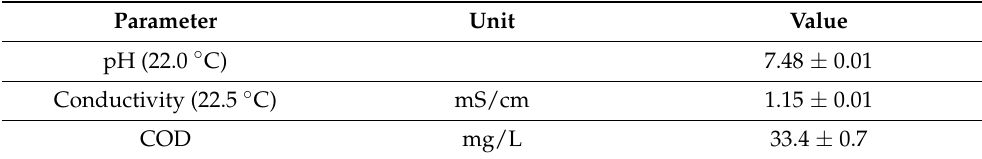
Table 1. Properties of effluent.